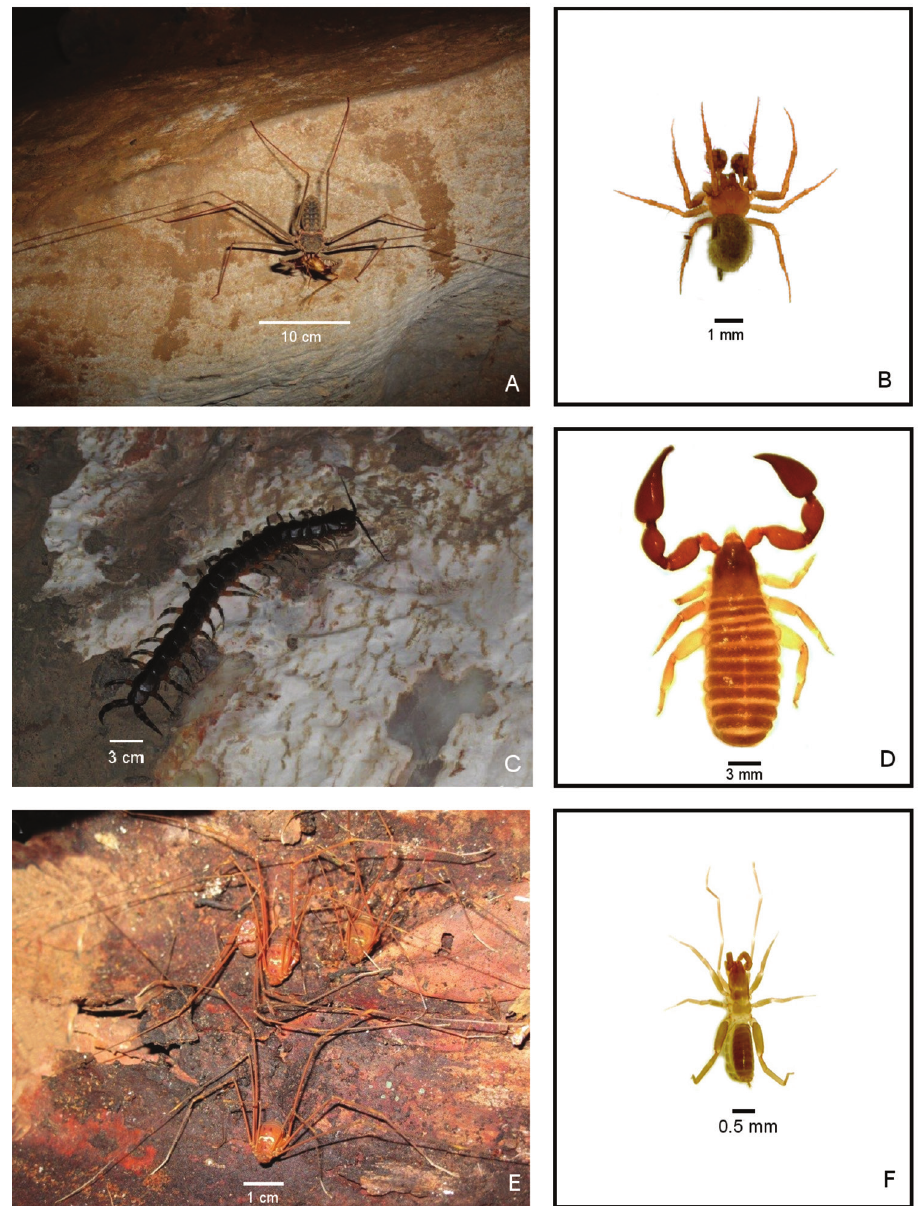
Figure 3. Fauna from caves of northeastern Goiás, central Brazil: A Heterophrynus longicornis (Amblypy- gi) preying a cricket Endecous sp. (Orthoptera: Phalangopsidae) B Nesticodes rufipes (Araneae: Theridiidae) C Scolopendra viridicornis (Chilopoda: Scolopendromorpha) D Chernetidae (Pseudoscorpiones) E Flirtea batman (Opiliones: Cosmetidae) F Stenochrus portoricensis (Schizomida: